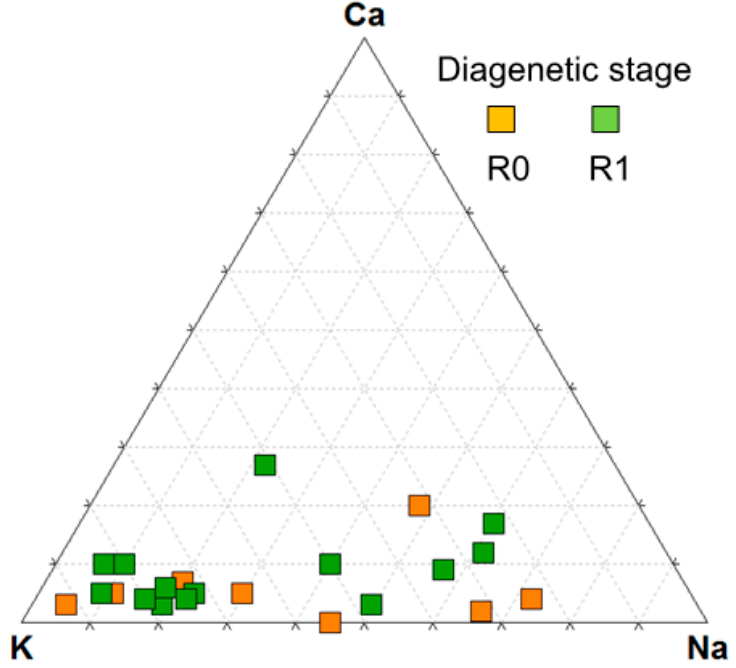
Figure 10. Triangular plot showing the cation composition of the interlayer of the illitic-micaceous clays (analyses with layer charge >0.75 per half unit cell in Figure 8).